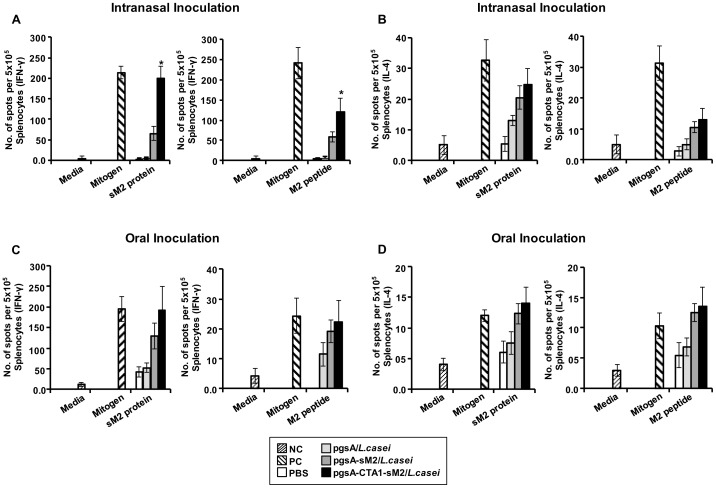
Determination of cytokine-producing splenocytes.Cytokines (IFN-γ and IL-4) were enumerated by ELISPOT at 7 days after the final immunization from the splenocytes. (A and C) Number of spots specific to IFN-γ per 5×105 splenocytes were stimulated with sM2 proteins (left) and M2 peptides (right) of the intranasally (top) and orally (bottom) immunized groups. (B and D) Number of spots specific to IL-4 per 5×105 splenocytes stimulated with sM2 protein (left) and M2 peptide (right) of the intranasally (top) and orally (bottom) immunized groups. NC denotes negative controls (non-immunized), and PC denotes positive controls, the cells stimulated with mitogen. Bars denote mean ± S.D. The asterisk indicates a significant difference between pgsA-CTA1-sM2/L. casei and other groups (*P<0.05).